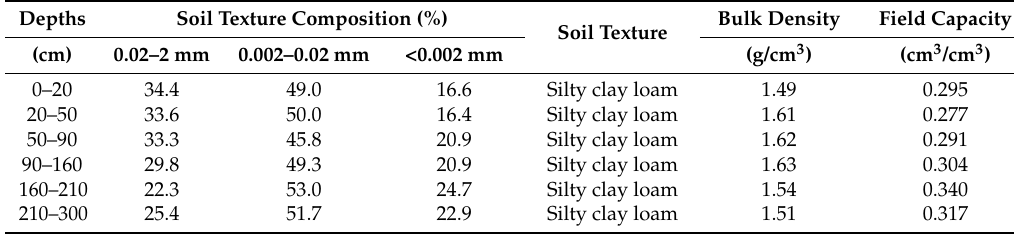
Table 1. The soil mechanical composition and physical parameters.